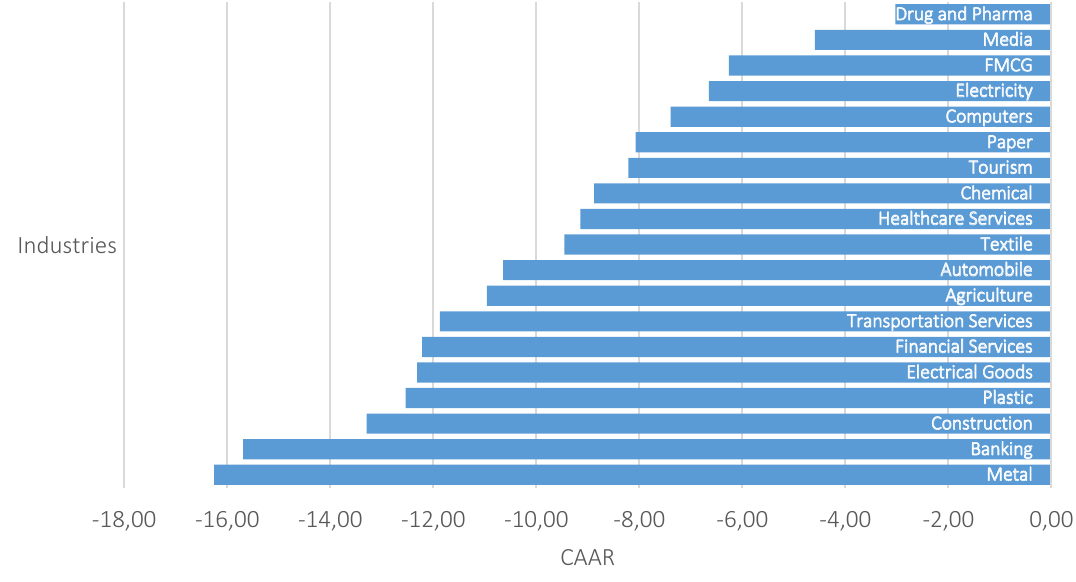
Figure 2. Impact of COVID-19 on different